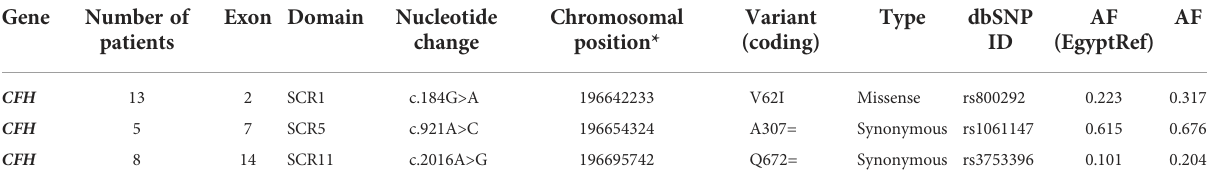
TABLE 6 Summary of benign common